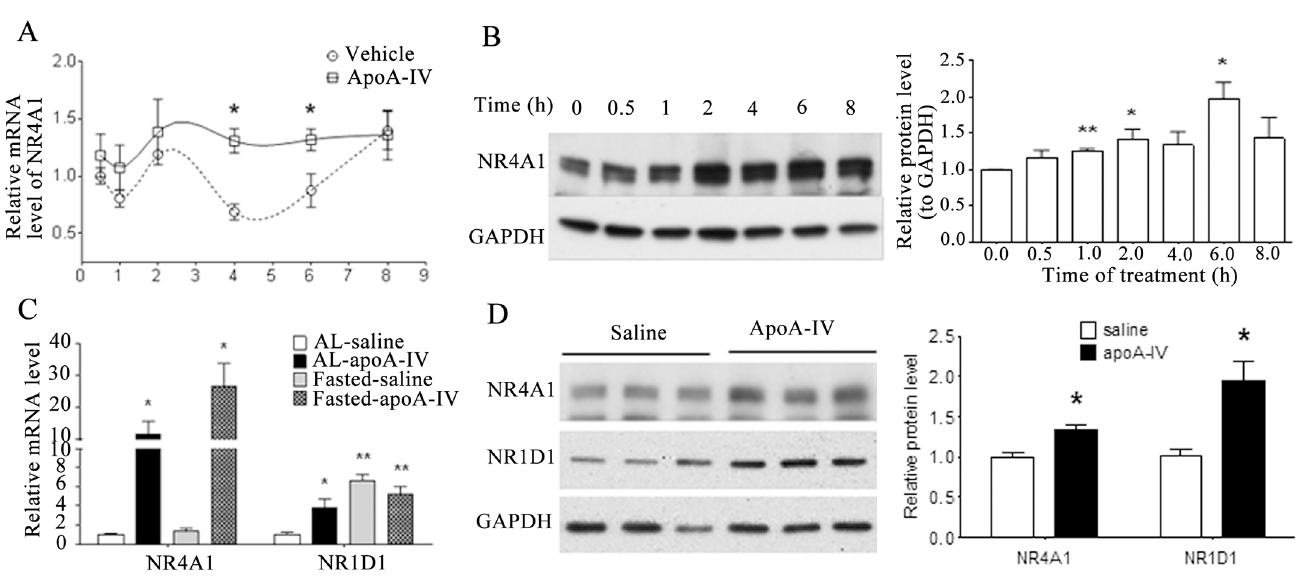
Fig 5. Effect of ApoA-IV treatment on NR4A1 gene expression in cultured cells in vitro and in vivo . Primary mouse hepatocytes were treated with 20 μ g/mL r-m-ApoA-IV or an equivalent volume of PBS (vehicle control). The level of NR4A1 (A) mRNA and (B) protein expression were measured relative to the cyclophilin control using qRT-PCR and western blotting, respectively. The data from three independent experiments are presented as the mean ± SE of at least three samples from three independent experiments ( * P < 0.05 and ** P < 0.01 vs vehicle). Mice (n = 5 each group) were provided food ad libitum (AL) or fasted for 5 h before receiving an intraperitoneal injection of 1 μ g/g r-m-ApoA-IV protein or saline (vehicle control). At 2 h postinjection, the levels of NR1D1 and NR4A1 (C) mRNA and (D) protein expression were measured, relative to the cyclophilin or GAPDH control, a using qRT-PCR and western blotting, respectively ( * P < 0.05 and ** P < 0.01 vs saline